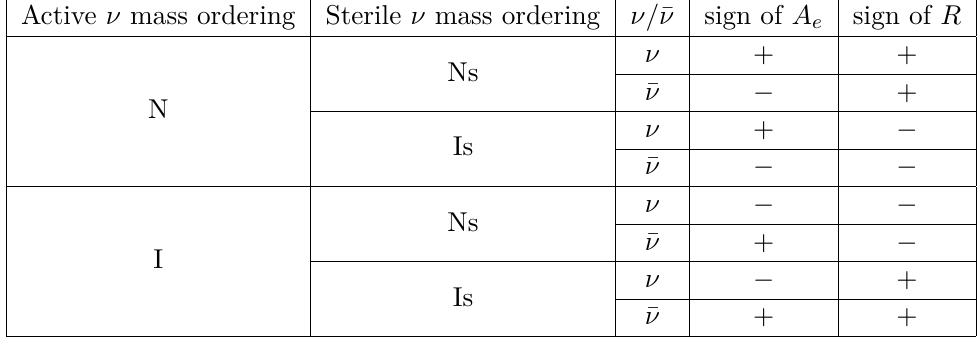
Table 4 . The signs of A e and R for all mass ordering combinations, for neutrinos and